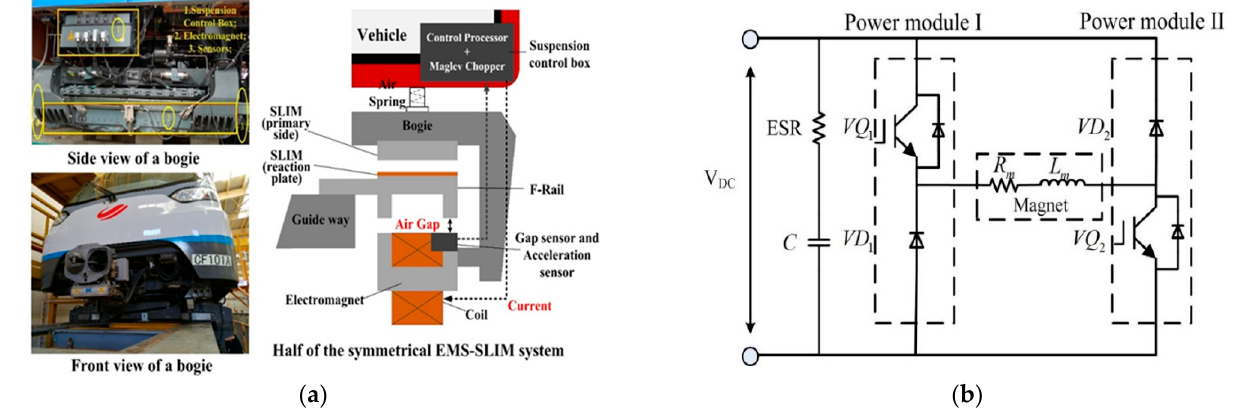
Figure 2. ( a ) Operation principle of Maglev train ( left ); ( b ) the circuit of Maglev chopper and a suspension electromagnet ( right ). suspension electromagnet ( right